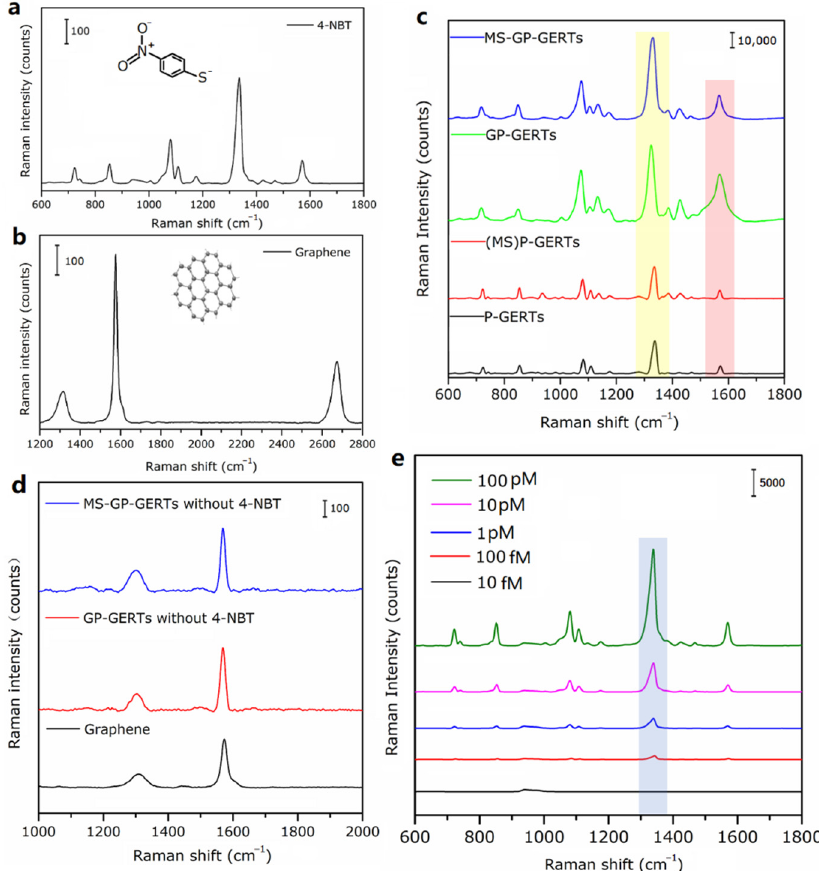
Figure 8. ( a ) Raman spectrum of 4-NBT on silicon substrate; ( b ) Raman spectrum of graphene on silicon substrate; ( c ) Raman spectra of P-GERTs, (MS)P-GERTs, GP-GERTs, and MS-GP-GERTs; ( d ) Raman spectra of composite structures MS-GP-GERT, GP-GERT, and graphene without 4-NBT molecules; ( e ) Raman spectra of different MS-GP-GERTs Raman tag concentrations.